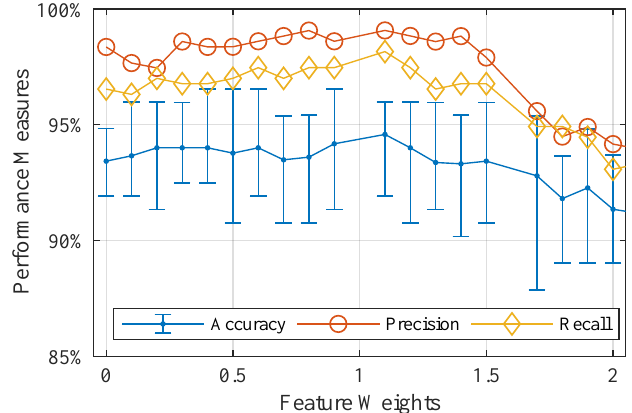
Figure 10. Quadratic SVMs cross-validated on different feature